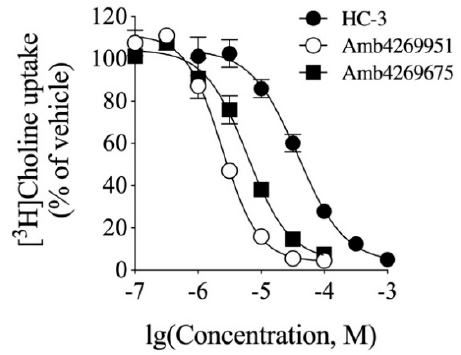
Figure 6. Effect of HC-3, Amb4269951, and Amb4269675 on [ 3 H]choline uptake in MIA PaCa-2 cells ( n = 3). Cells incubated with HC-3, Amb4269951, and Amb4269675 for 20 min and then 10 µM [ 3 H]choline uptake measured for 20 min. Results calculated as 100% of findings in vehicle control. IC 50 values of HC-3, Amb4269951, and Amb4269675 for inhibition of [ 3 H]choline uptake were 38.4, 2.4, and 6.0 µM, respectively.